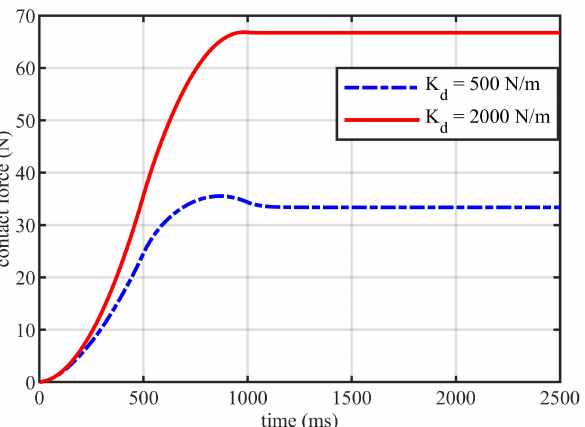
Figure 6. Robot’s contact forces with the wall in the horizontal direction under different stiffness parameters.